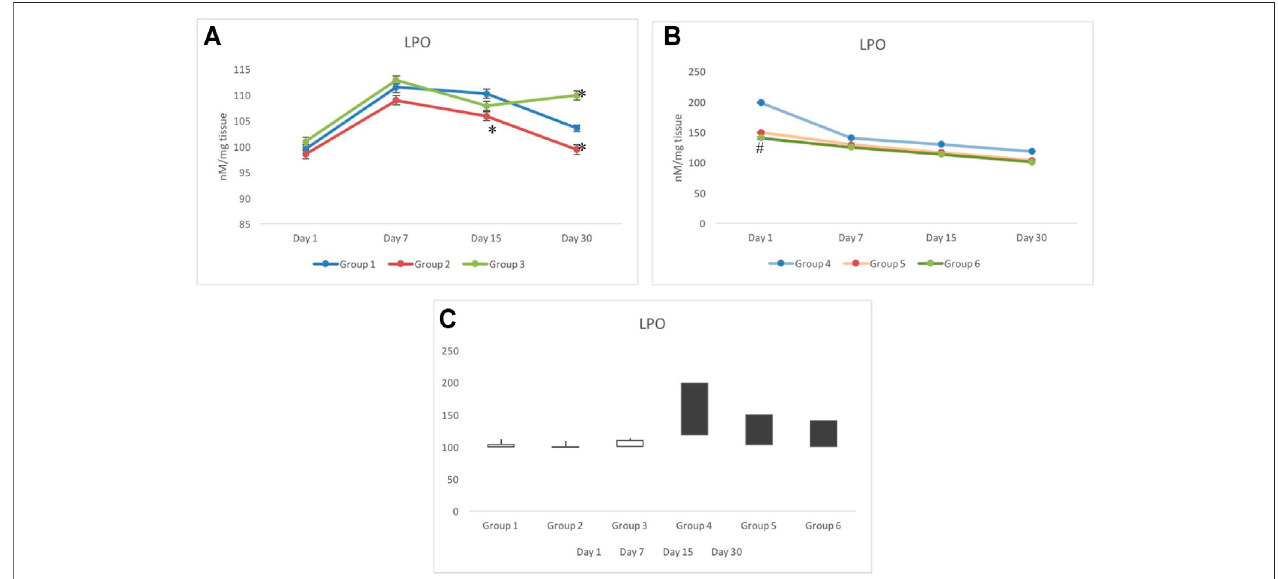
FIGURE 3 | Variation in lipid peroxidation (LPO) in non-exposed (A) and exposed groups (B) . The stock plot indicates highest and lowest peroxidation levels from day 1today30 (C) .Thewhiteboxindicatesthegaininperoxidation, whereas theblack boxindicatesthelossinperoxidation.* p < 0.05signi fi cance levelwasmeasured against group 1. # p < 0.05 signi fi cance level was measured against group